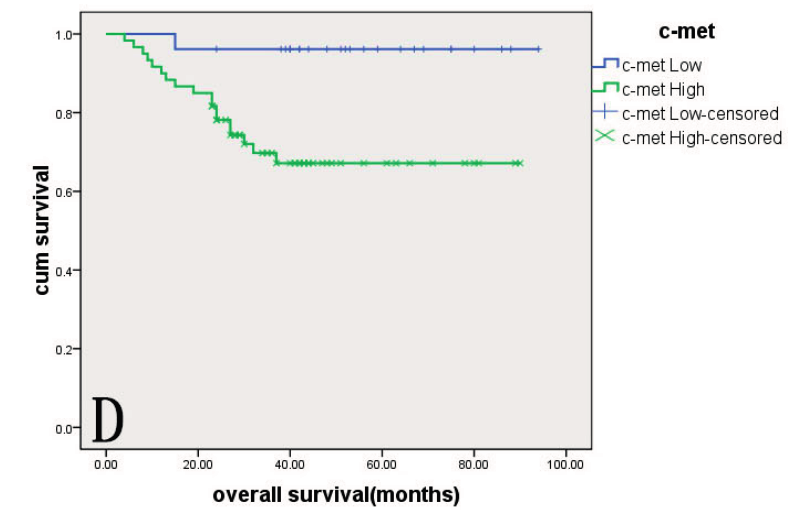
Figure 2. The association between overall survival, CD44, CD47, c-met expression and surgical stage in 86 patients with OCCC. ( A ) Patients with Stage I/II disease showed